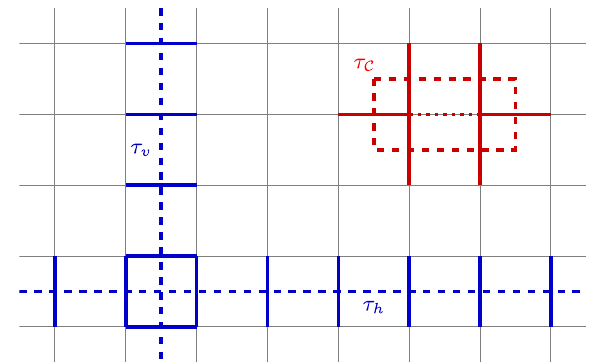
FIG. 2. The two noncontractible ’t Hooft loops τ h , τ v and a simple example of how a contractible ’t Hooft loop operator τ C is written as a product of star operators. The dotted link indicates ) 2 = a cancelation due to ( ˆ σ x l